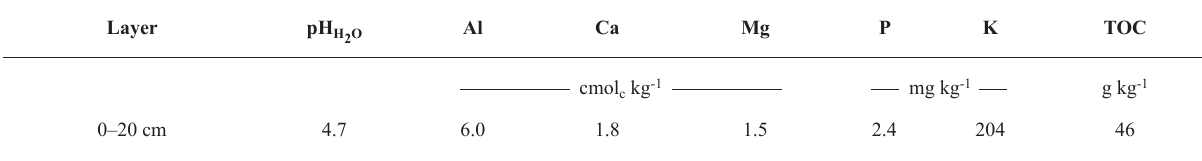
table 1. chemical analysis of the 0–20 cm layer of the humic cambisol. Bocaina do sul, sc